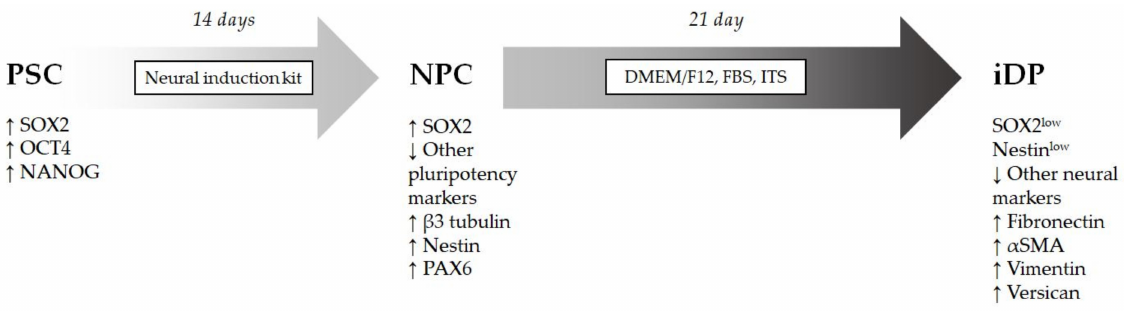
Figure 1. Differentiation of pluripotent stem cells into dermal papilla